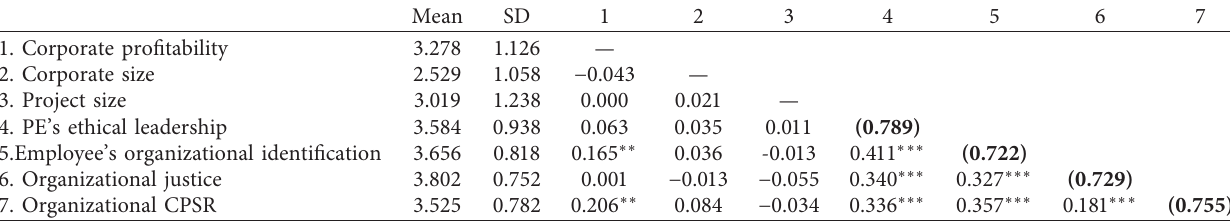
Table 3: Means, standard deviations, and correlations of variables.